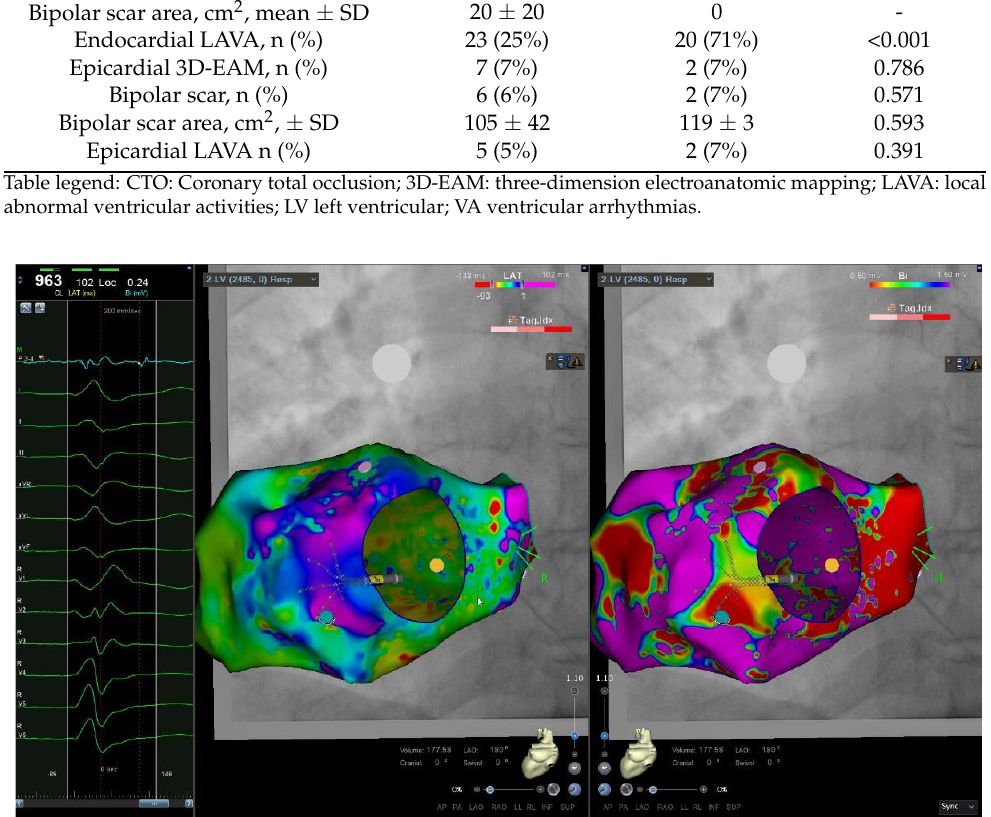
Figure 3. Local abnormal ventricular activities and substrate endocardial 3D-EAM of left ventricle in patient with CTO. ( Left Panel ): left ventricular endocardial electrograms during 3D-EAM: local abnormal ventricular activities recorded after QRS during left ventricular 3D-EAM in sinus rhythm of patient with LCA-CTO. ( Central Panel ): activation mapping during sinus rhythm of patient with LCA-CTO; the green dot is the site of recorded LAVA in lateral basal left ventricular wall. ( Right Panel ): bipolar endocardial 3D-EAM of left ventricle of patient with LCA-CTO with evidence of dense scar (red zone with potentials < 0.5mV) and border zone (green and blu zones with potentials ranging 0.5 – 1.5 mV) in lateral basal left ventricular wall.